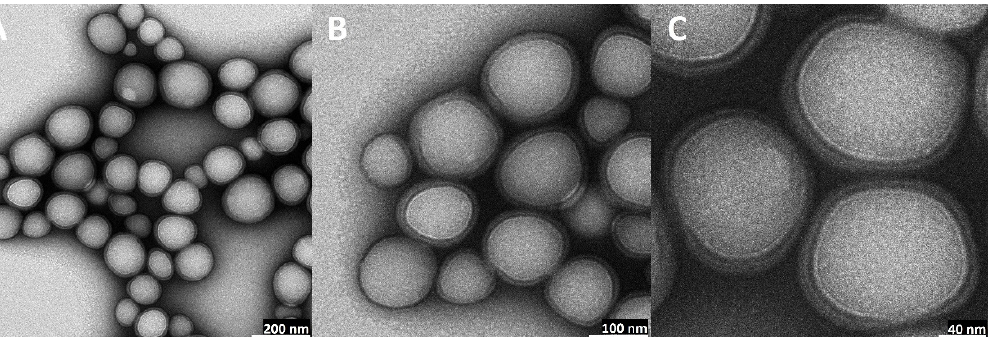
Figure 10. TEM images of bare PLGA nanoparticles: ( A ): magnitude 50 k, scale bar 200 nm; ( B ): magnitude 100 k, scale bar 100 nm; ( C ): magnitude 200 k, scale bar 40 nm.